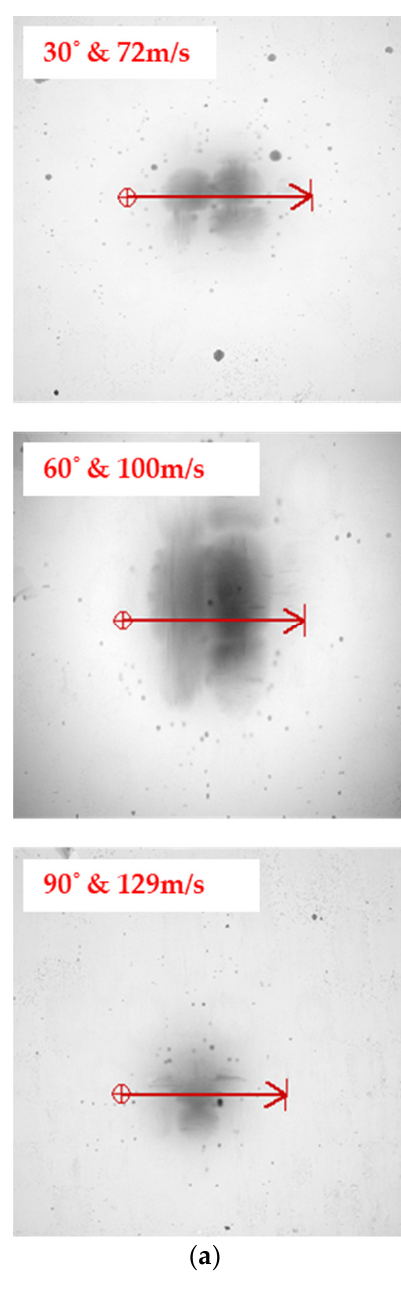
Figure 8. Eroded surface view for 5k samples: ( a ) microscopic view and ( b ) 3D surface profilometer image.